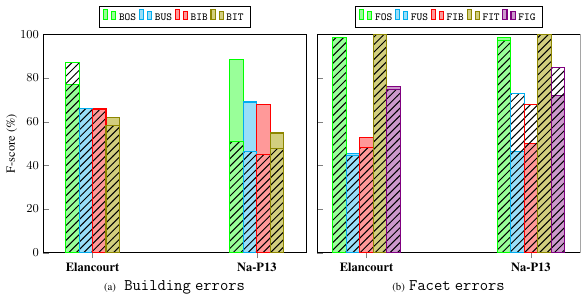
Figure 7. Transferability F-scores obtained with an SVM using graph kernels features (colors). Hash bars: Vanilla F-scores of Figure 5.